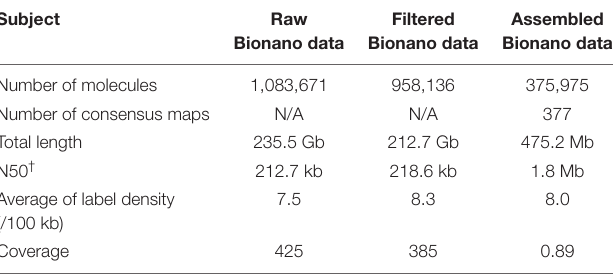
TABLE 1 | Statistics of cv . Yarloop Bionano optical